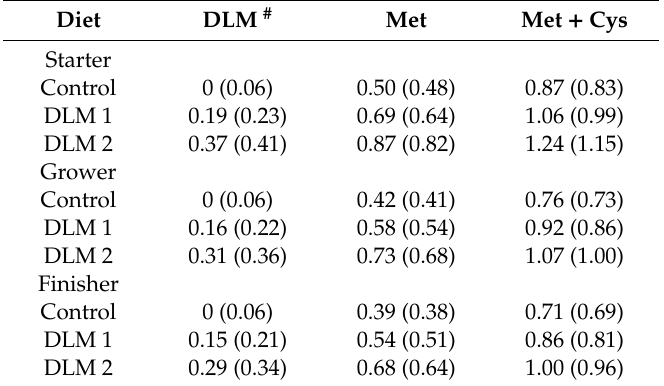
Table 2. Dietary supplementation levels of DLM and concentrations of free Met, Met, and Met + Cys in the diets (%)